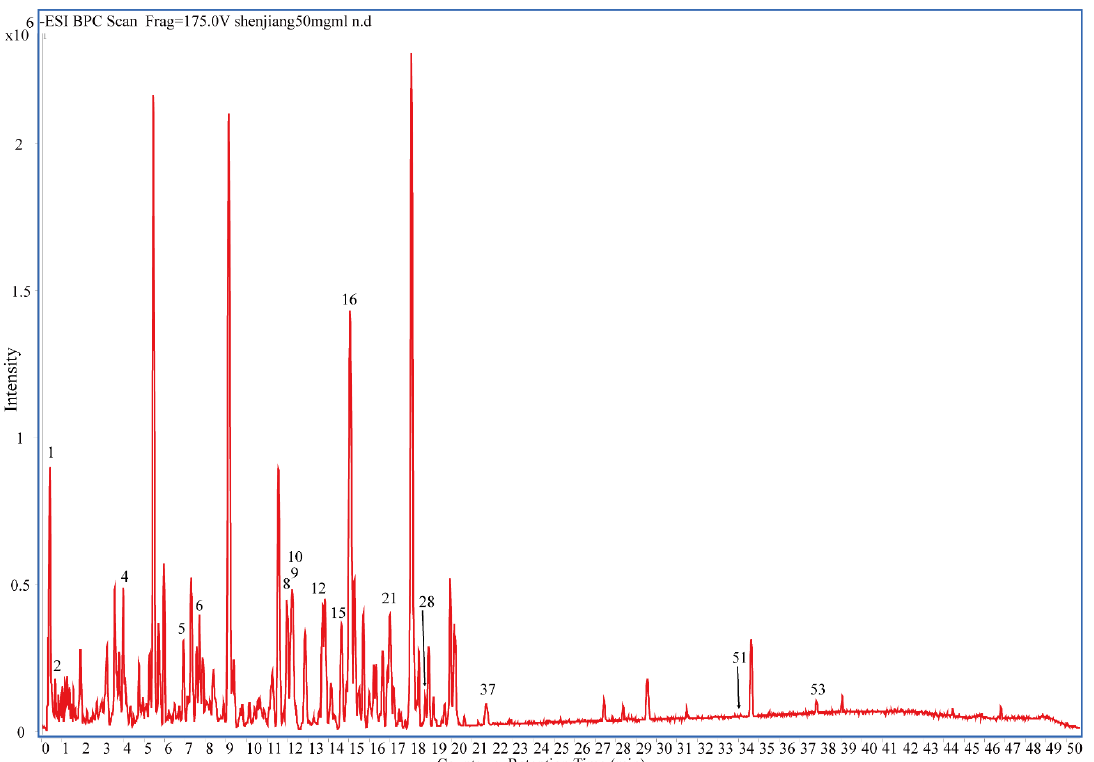
Figure 2. ( − )-ESI base peak chromatogram (BPC) of the dried ginger water extract by UHPLC–ESI- Figure 2. (−) -ESI base peak chromatogram (BPC) of the dried ginger water extract by UHPLC – ESI- QTOF-MS.